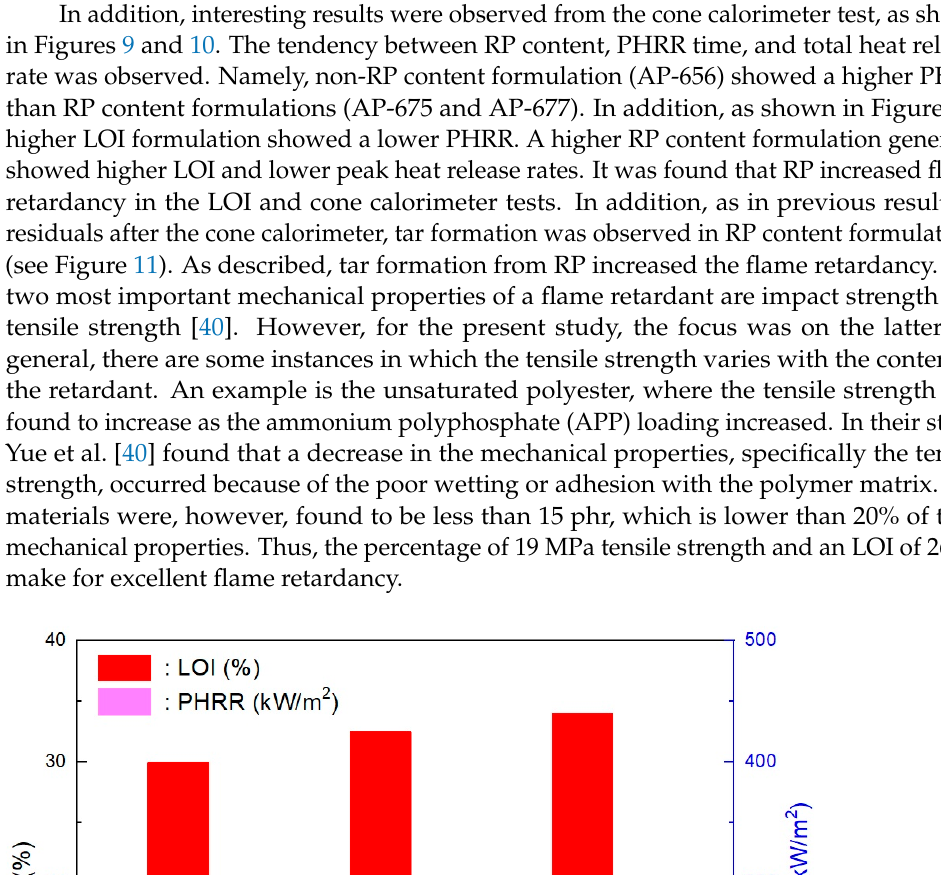
Figure 10. Heat release rate curves of AP ‐ 656, AP ‐ 675 and AP ‐ 677 as a function of burning time.